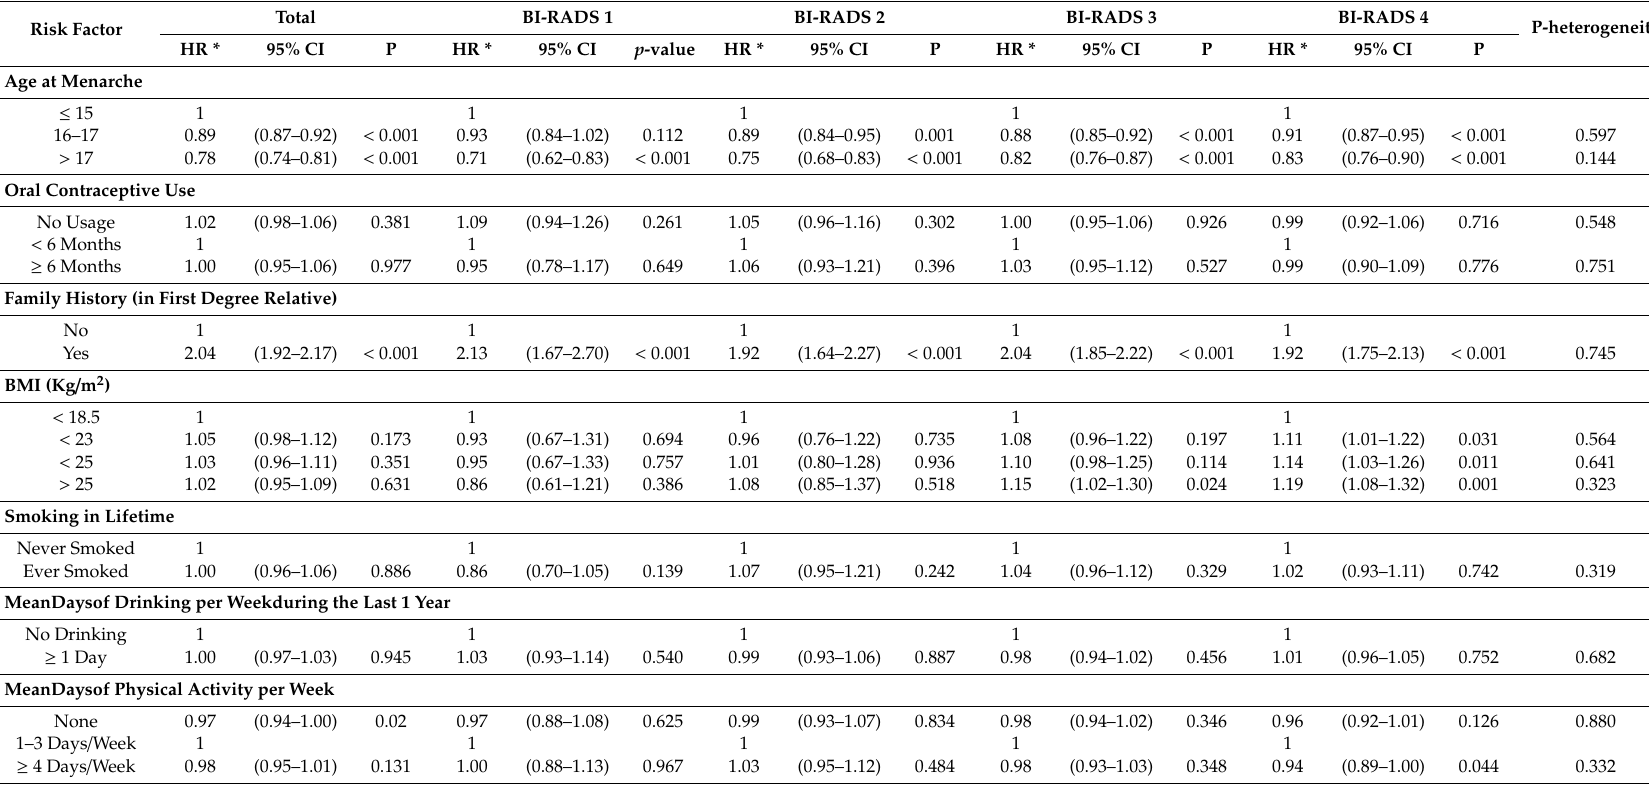
Table 3. Association between known risk factors of breast cancer and breast cancer development by breast density in premenopausal